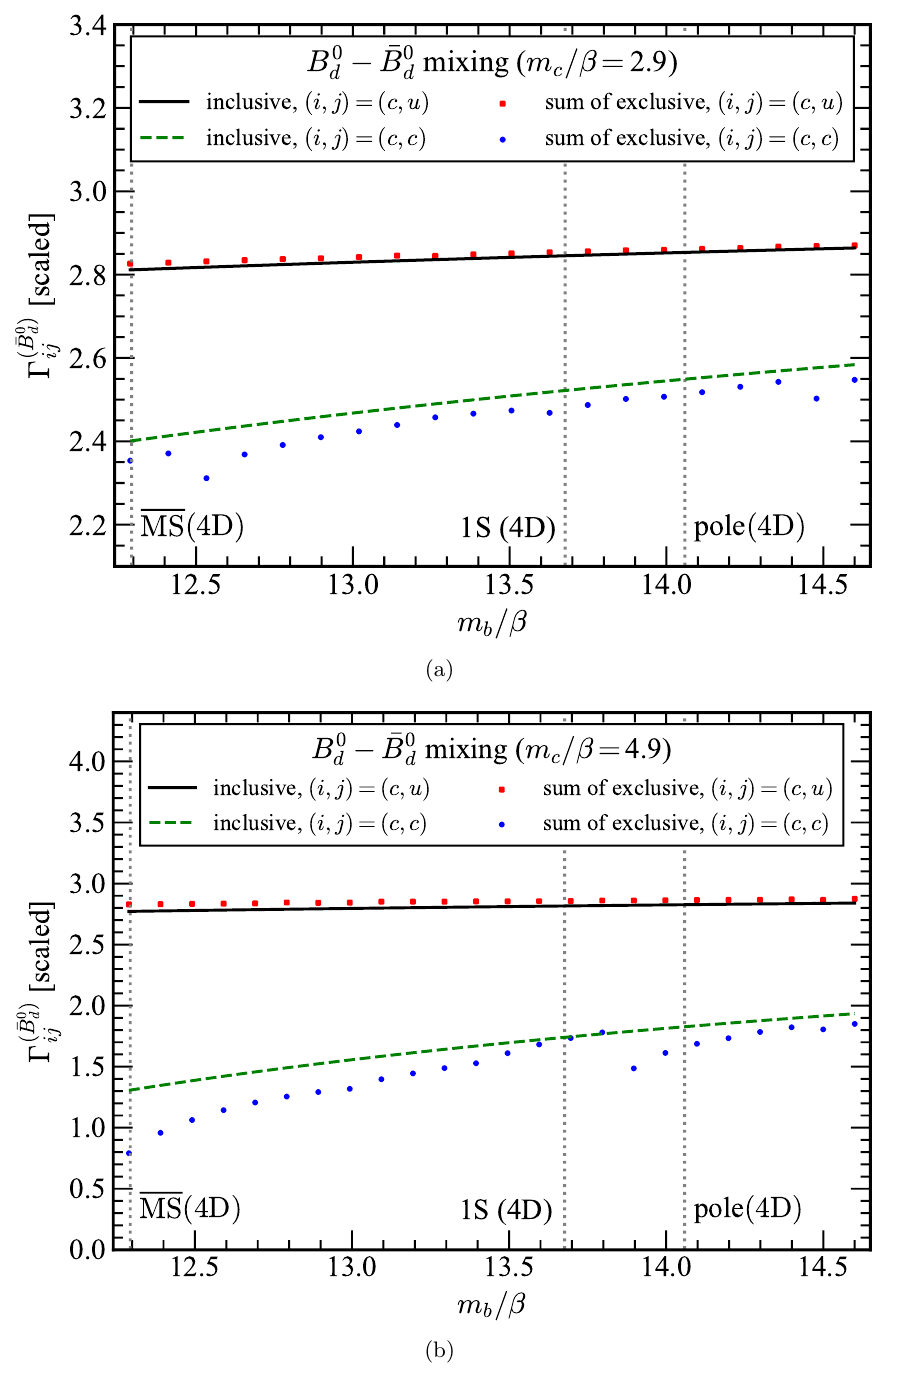
¯ mixing: (a) m − B 0 d d